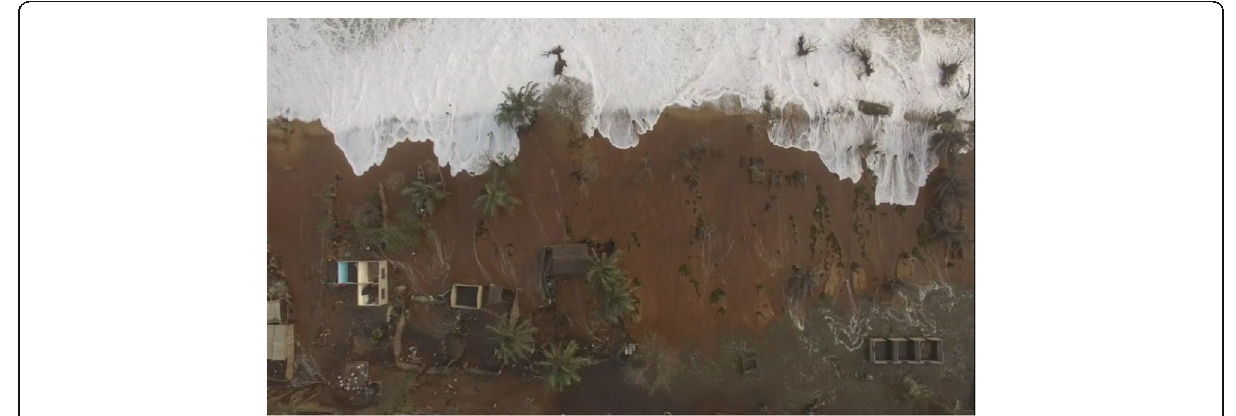
Fig. 8 Violent sea waves approaching the Fuvemeh community on 9th February 2016